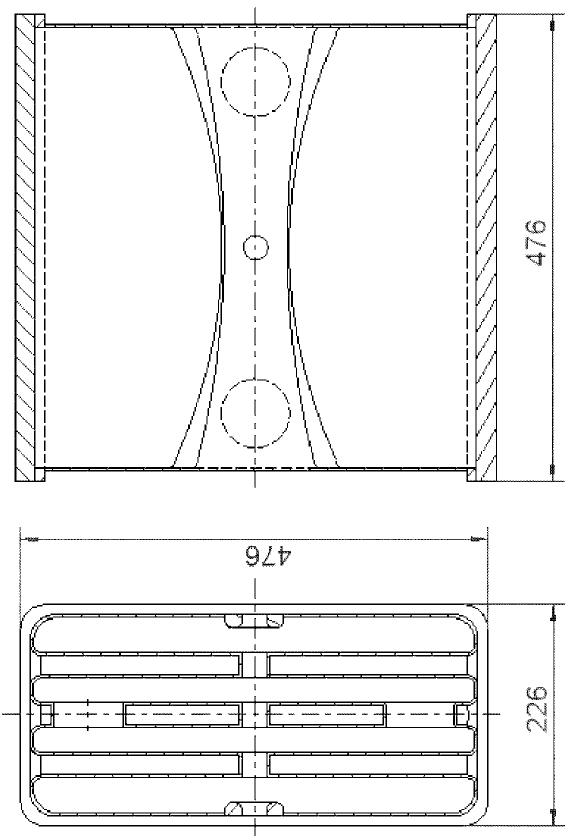
FIG. 5. 2D cross section and front view of the ladder cavity; a preliminary estimation of the external size is shown in the plot.